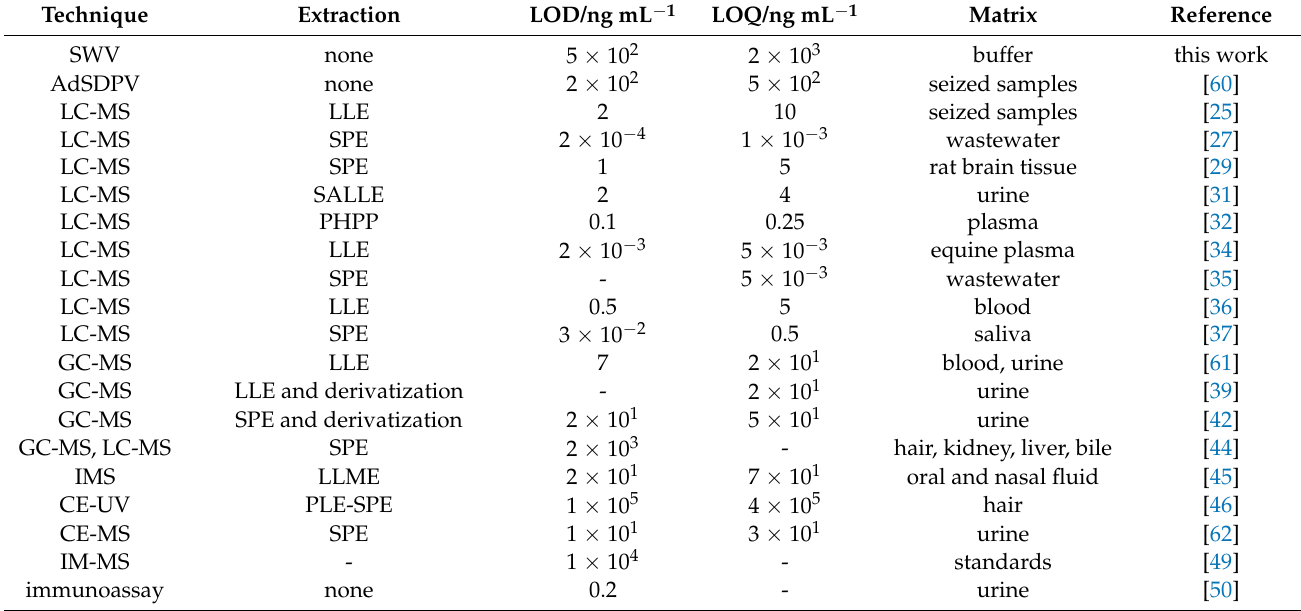
Table 1. Analytical methods reported for